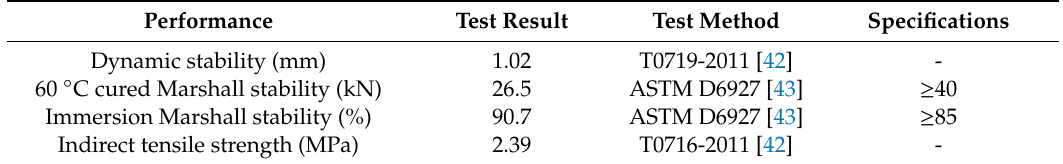
Table 2. Technical performances and specifications for the GA mixture.